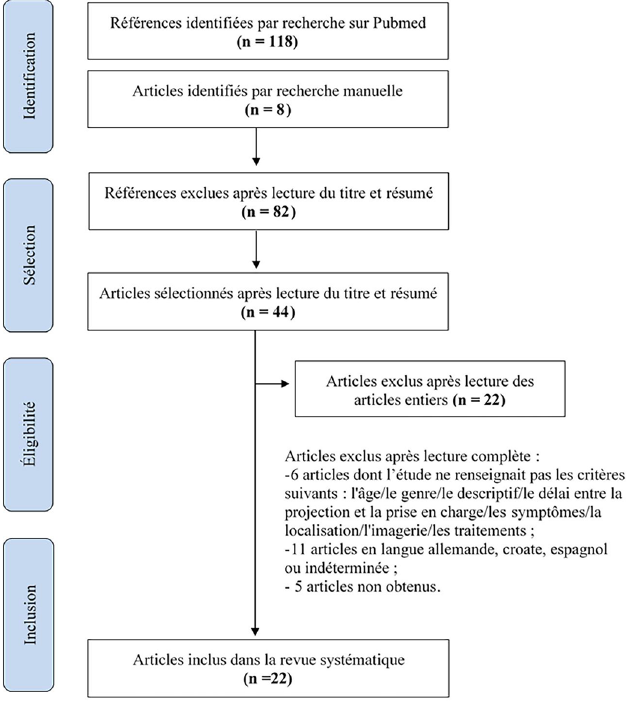
Fig 1. PRISMA fl owchart of the systematic literature